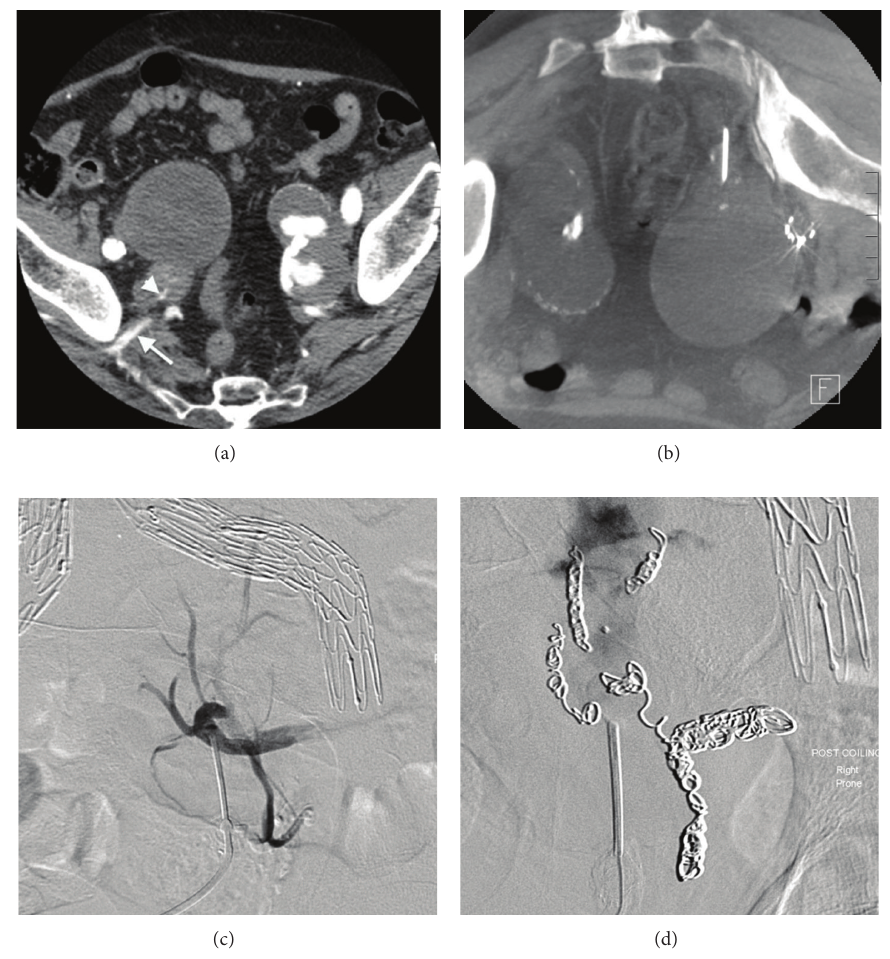
Figure 1: (a) Axial CT demonstrating bilateral internal iliac artery aneurysms, and contrast can be seen entering the right IIA aneurysm ( arrowhead ) via the superior gluteal artery ( arrow ). (b) Prone axial CT showing the needle cannulating the superior gluteal artery after traversing sciatic notch. (c) Prone angiogram with the needle in the superior gluteal artery demonstrating communication with five feeding vessels. (d) Angiogram postcoiling of vessels demonstrating no perfusion of aneurysmal sac of filling